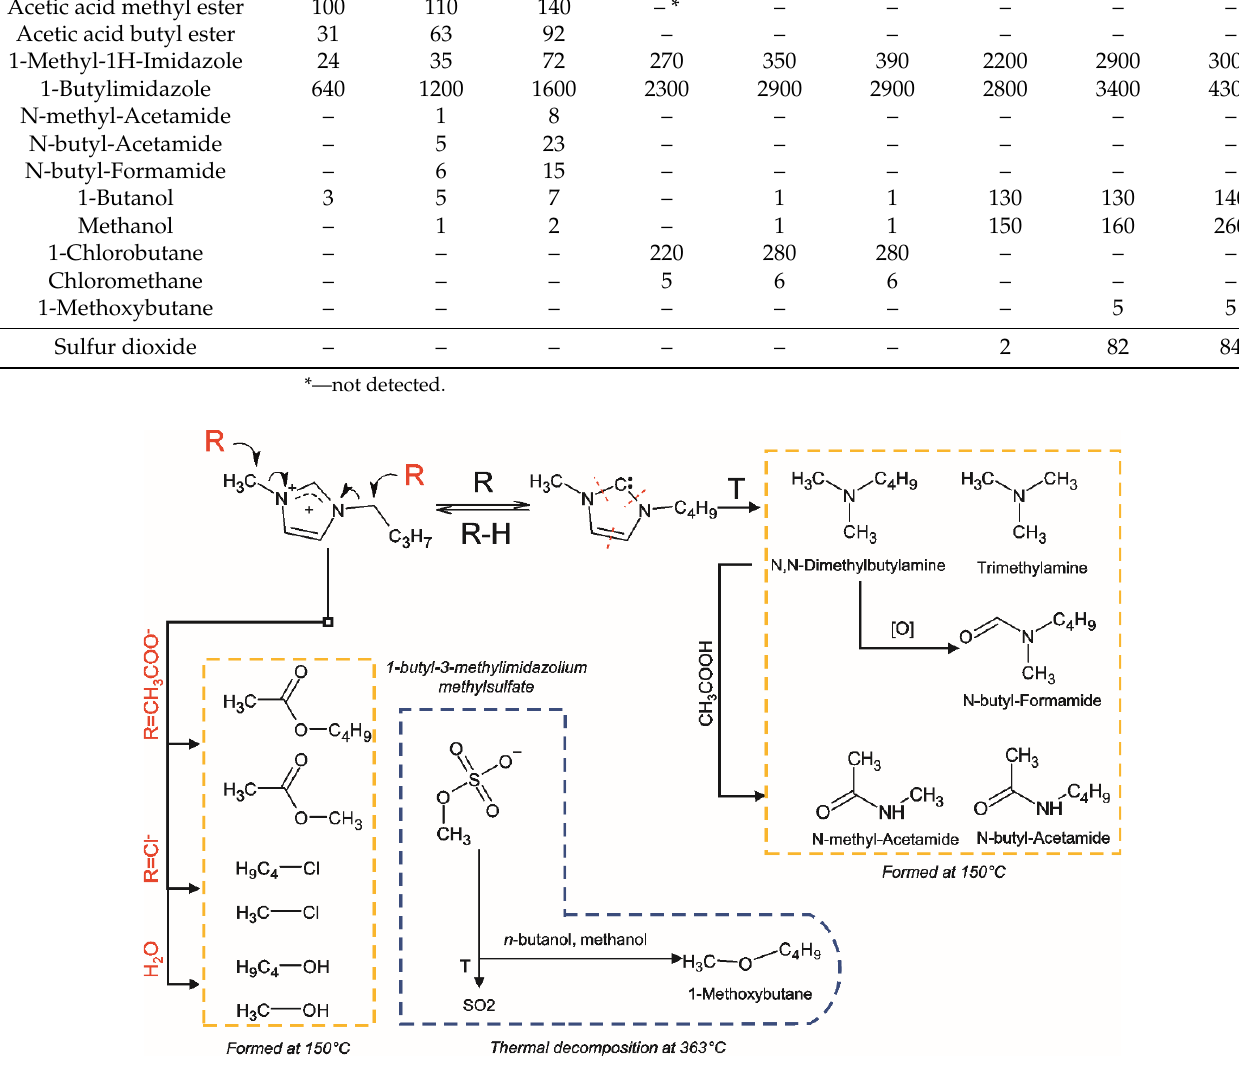
Figure 2. Thermal degradation pathways of the bmim-based ILs with the formation of volatile and semi-volatile compounds.